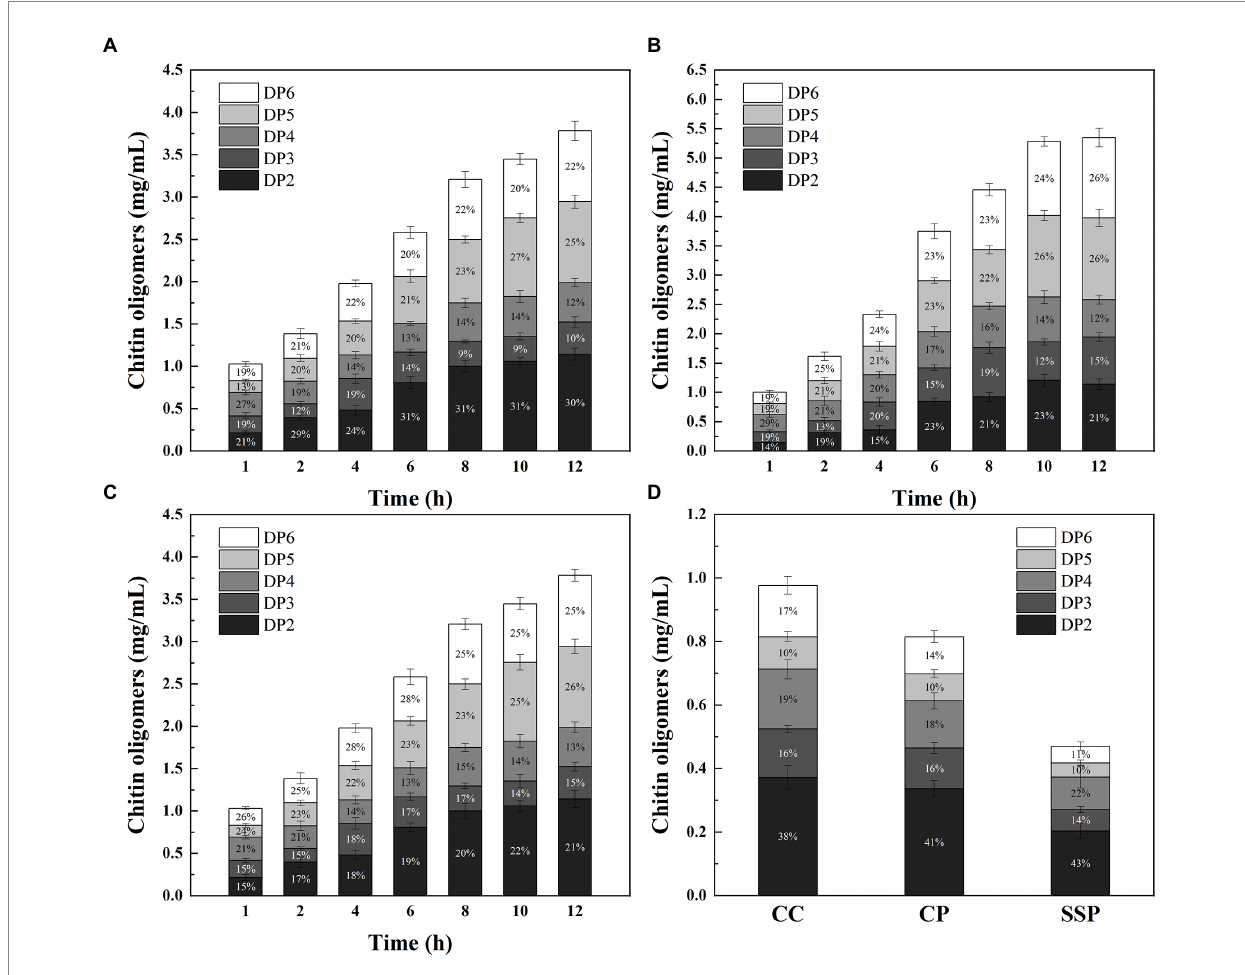
FIGURE. 6 Time course of COS production from CC (A) , CP (B) and SSP (C) degradation by CDEC; (D) Time course of COS production from CC, CP and SSP degradation by